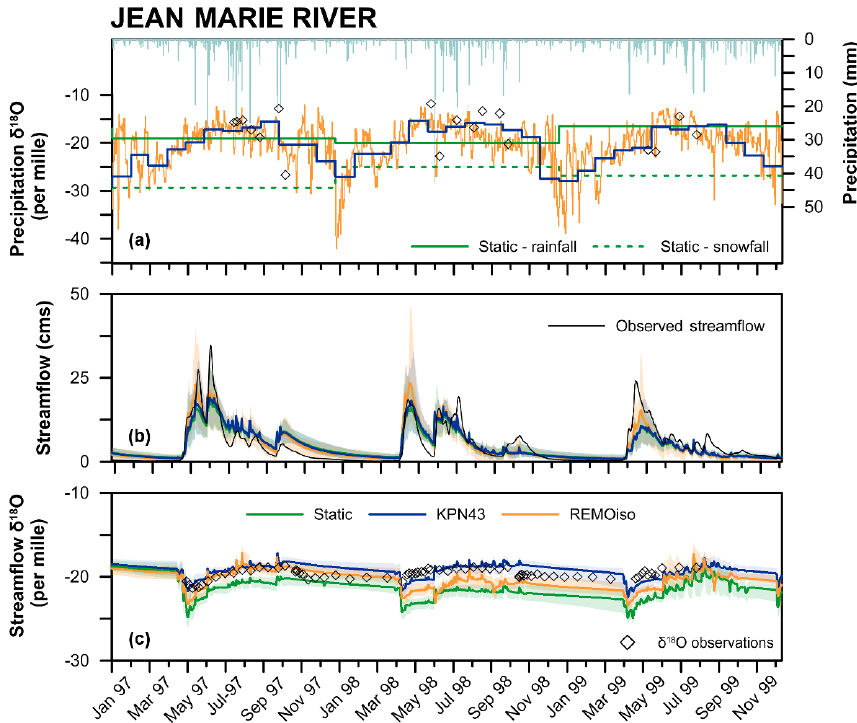
Figure 3. Input and behavioural simulations for Jean-Marie, including (a) KPN43, REMOiso, and static δ 18 O ppt input time series and daily precipitation; and simulated (b) mean daily streamflow and uncertainty bounds and (c) mean daily δ 18 O SF and uncertainty bounds, for KPN43, REMOiso, and static driven model calibrations. δ 18 O ppt input-specific uncertainty bounds are represented as the shaded regions, with shading colour corresponding to δ 18 O ppt type.